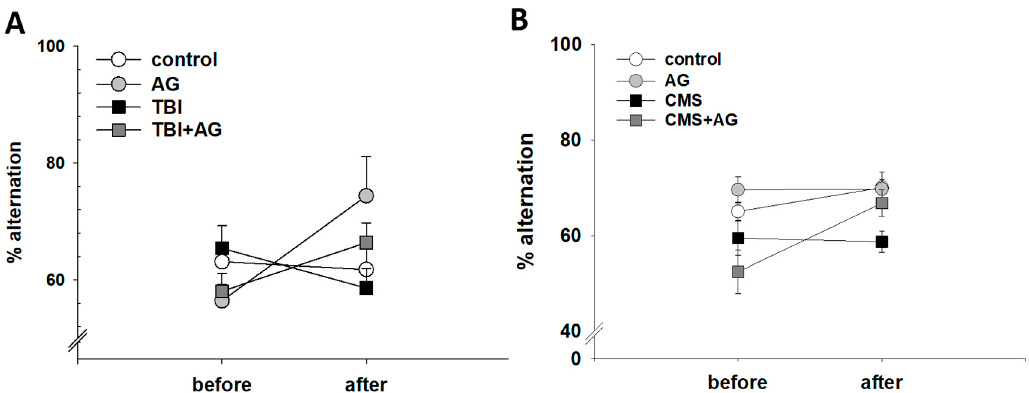
Figure 2. Short-term working memory by AG in TBI and CMS mice, measured by the percent alternation in the Y-maze. ( A ) TBI model. There were before–after (within) e ff ects [F(1,28) = 3.57, p = 0.012], treatment group (between) e ff ects [F(3,28) = 3.23, p = 0.081], and within–between interactions [F(3,28) = 3.28, p = 0.036]. There were no before–after changes in the control ( p = 0.6) and TBI ( p = 0.38), but improvements in the AG ( p = 0.008) and TBI + AG ( p = 0.047). ( B ) CMS model. There were before–after e ff ects [F(1,36) = 6.2, p = 0.018] and treatment group e ff ects [F(3,36) = 11.8, p < 0.001], but no significant within–between interaction di ff erences [F(3,36) = 1.5, p = 0.24]. There was no